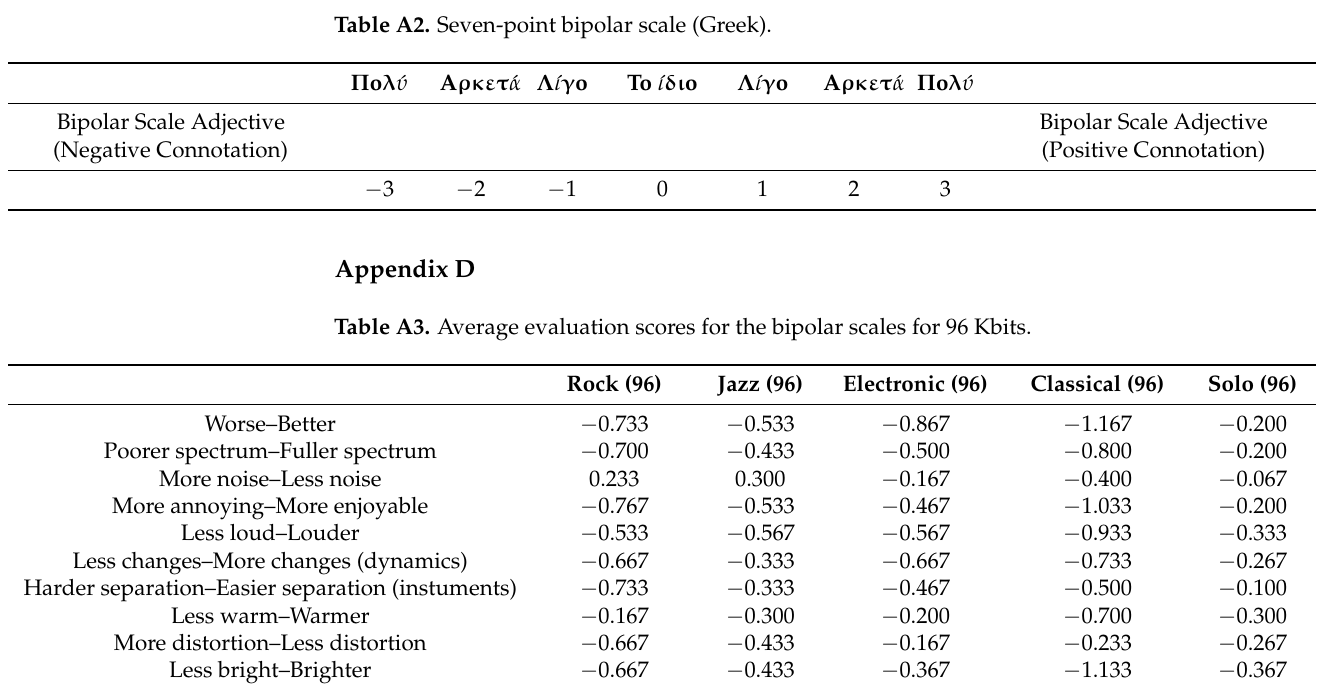
Table A3. Average evaluation scores for the bipolar scales for 96 Kbits.